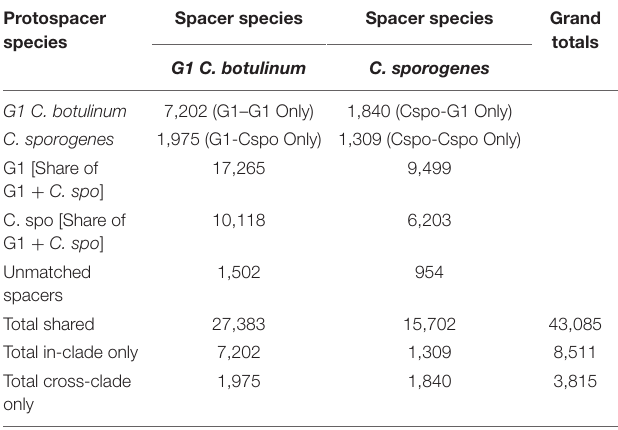
TABLE 4 | Directed force